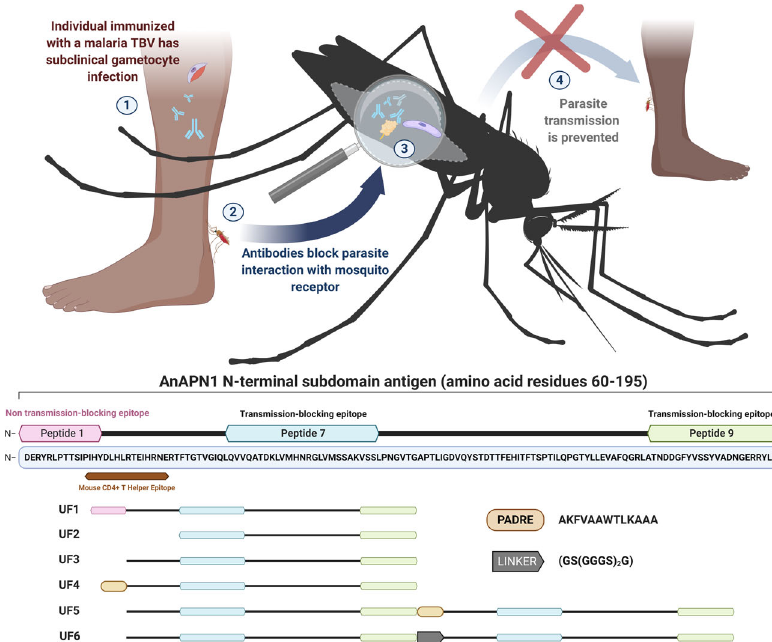
Fig. 1 Design of AnAPN1 transmission-blocking vaccine (TBV) constructs. ( Top ) Schematic depicting malaria mosquito-based TBV mode of action, wherein antibodies generated in a human host ➀ are taken up by the mosquito ➁ and prevent parasite (purple)-protein receptor (yellow) interaction ➂ and subsequent development within the mosquito, effectively blocking the spread of parasites within a community ➃ . (Bottom) AnAPN1 subdomain antigen design. Several second-generation immunogen constructs of AnAPN1 were developed based on structural and functional information for peptides 1, 7, and 9 (note: peptide numbers were not assigned sequentially from left to right). The location of a Mouse T Helper Epitope (brown) identi fi ed through the Epitope Identi fi cation Suite (Merck Research Labs) is indicated 7 , which overlaps with the carboxyterminal side of peptide 1. AnAPN1 constructs; UF1: Original AnAPN1 design, UF2: Mouse T Helper Epitope Deletion, UF3: Peptides 2-9 only, UF4: [PADRE: AKFVAAWTLKAAA] + Peptides 2-9 (UF3), UF5: UF3 + PADRE + UF3 construct, UF6: UF3 + [Glycine Linker: GS(GGGS) 2 G] + UF3. (Protein domains are not drawn to scale). See Supplementary Table 1 for additional